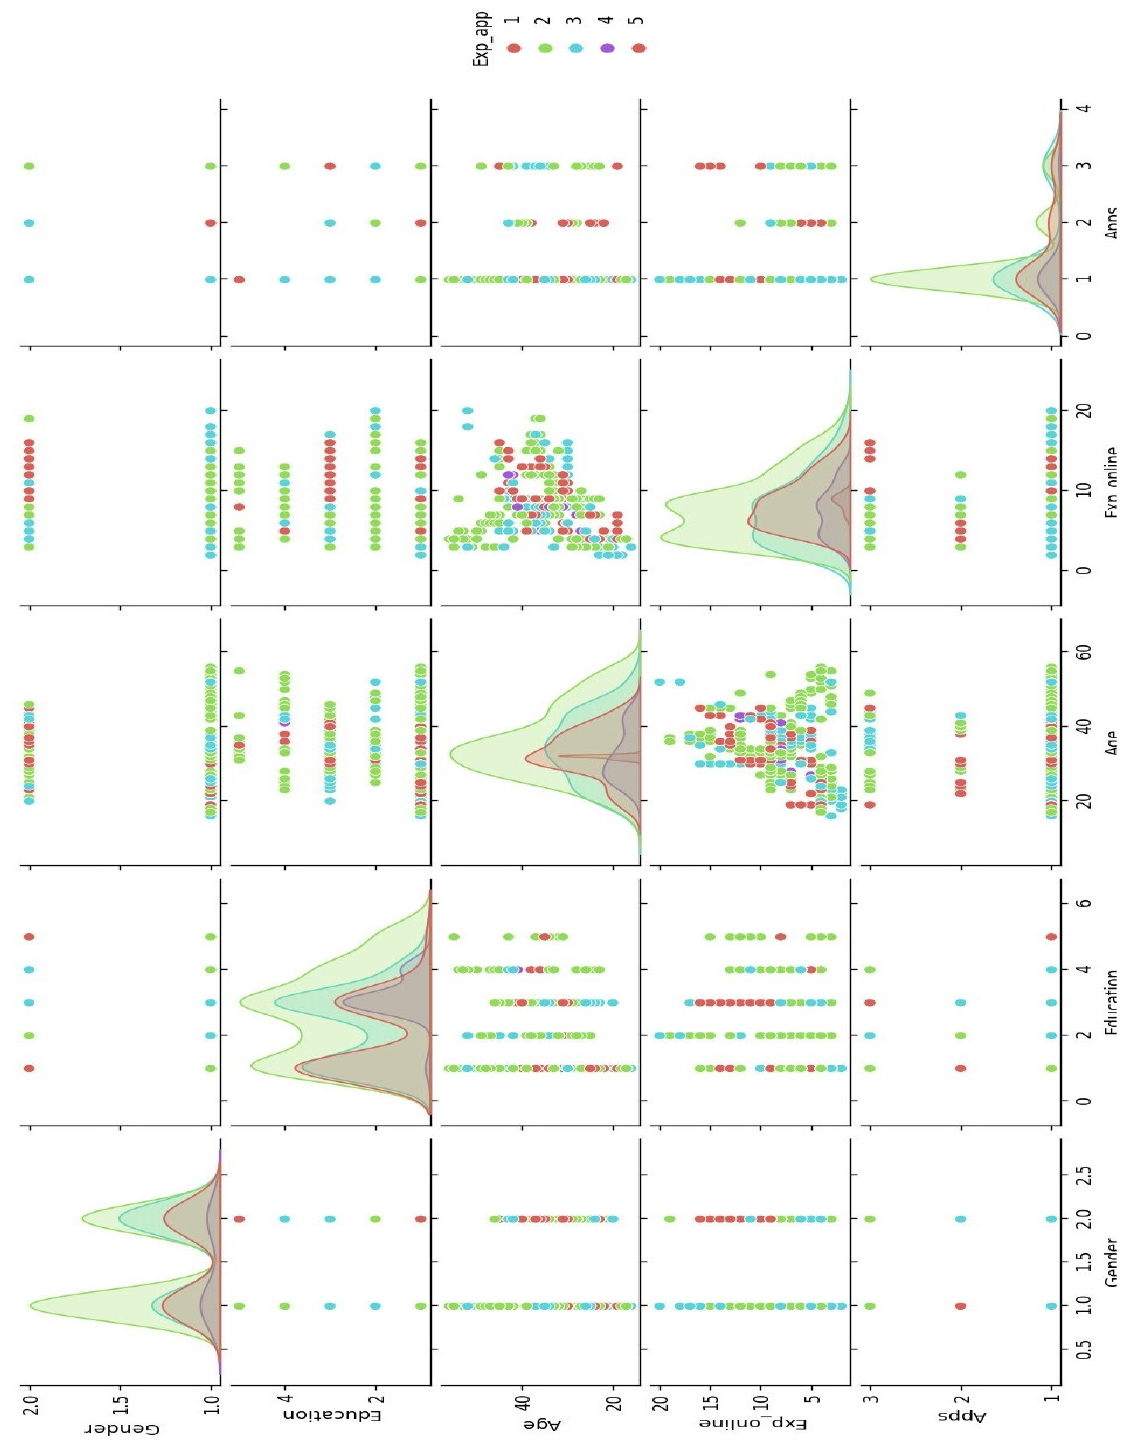
Figure 1. The pair plot of the respondents’ demographic data in Iran (source: authors’ calculations based on Python programming; Seaborn package; VS Code editor).